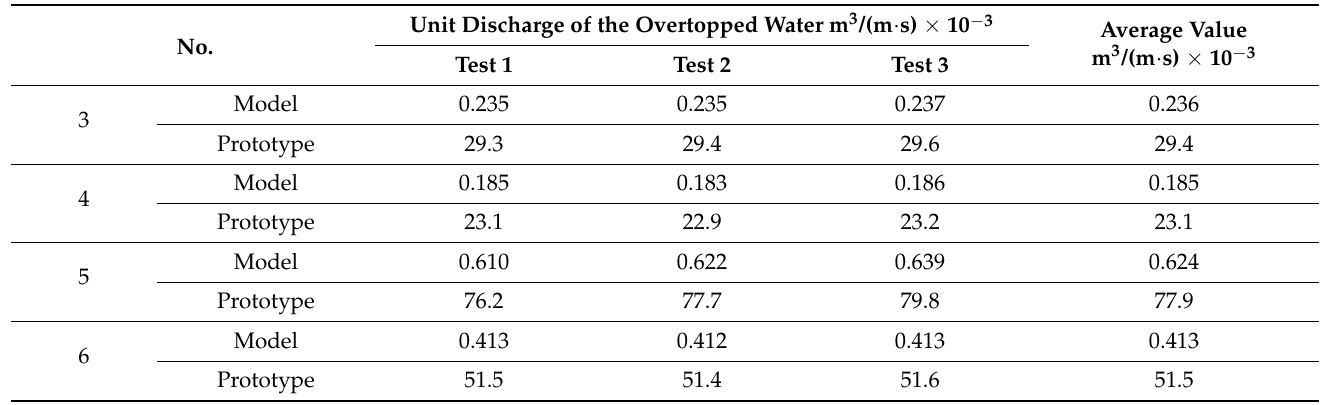
Table 2. Wave overtopping volume under different test